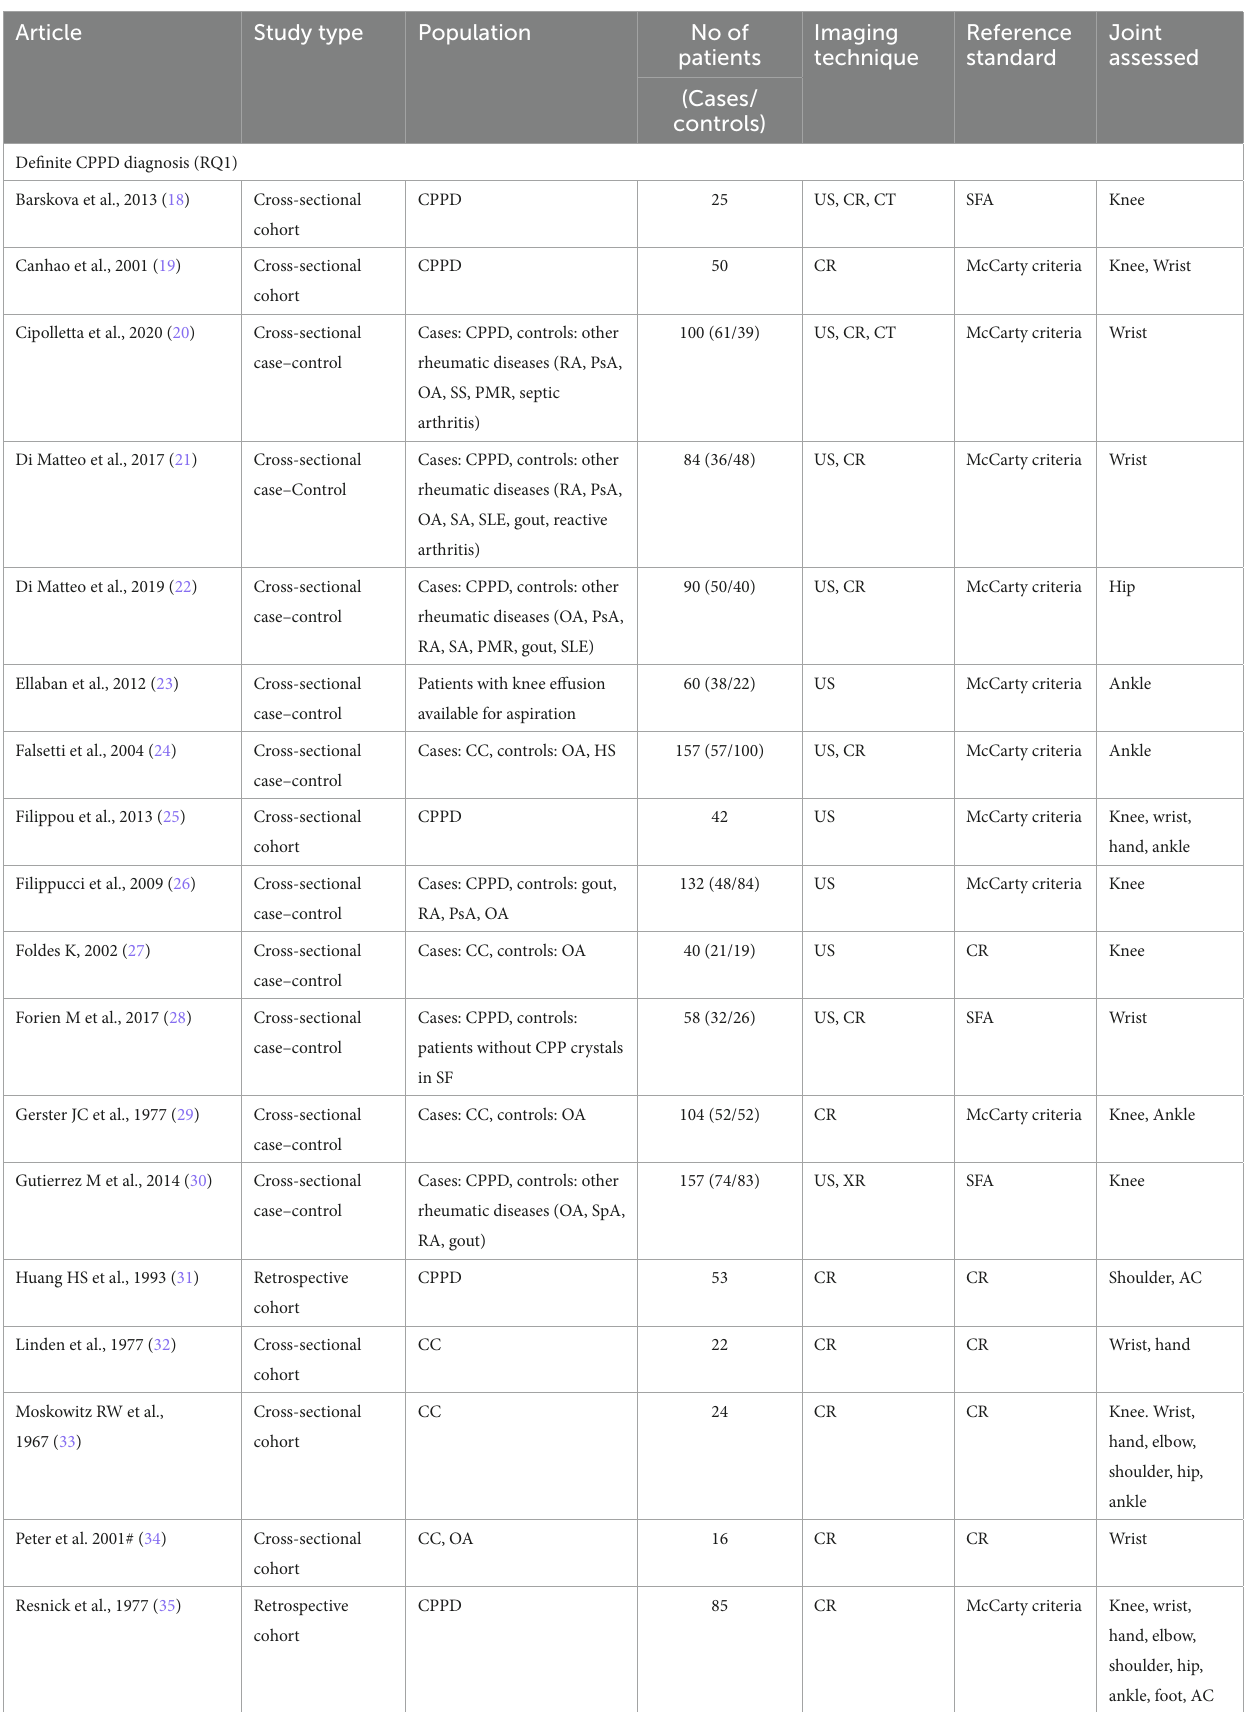
TABLE 1 Characteristics of the articles entered in the